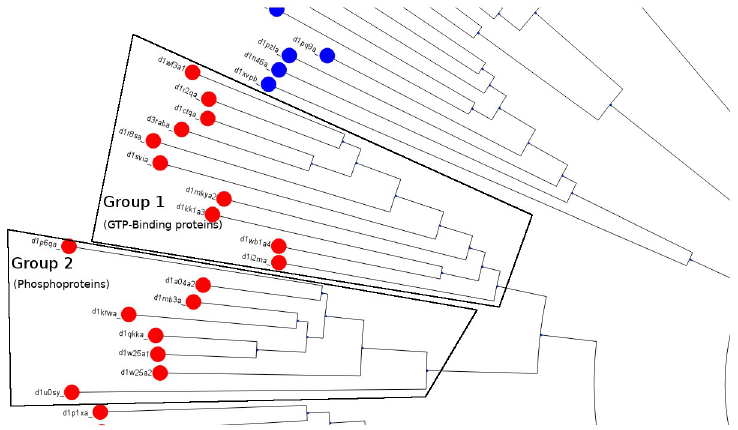
Fig 5. The unrooted Phylogenetic Tree based on median MCPSC consensus scores. Domains are colored according to their SCOP class (Level 1). Domains of the two clades that are marked belong to Class C but represent different functional groups (see Table C in S1